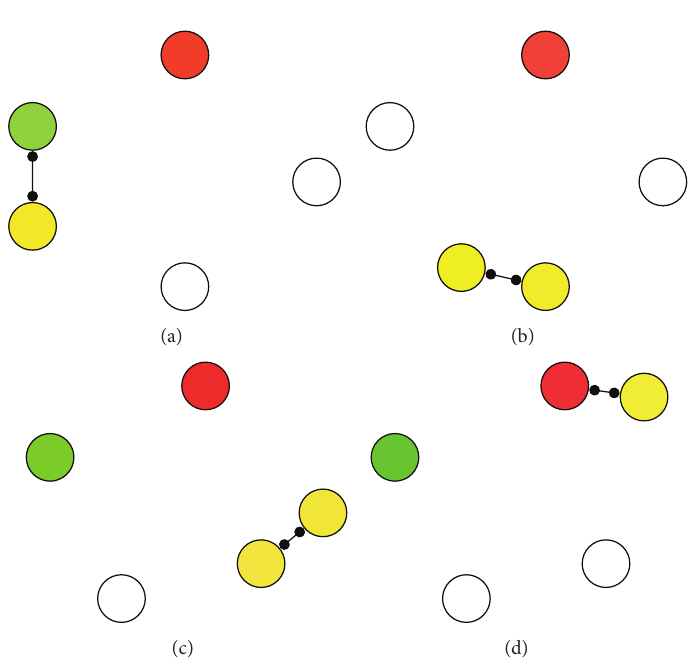
Figure 2: Routing in